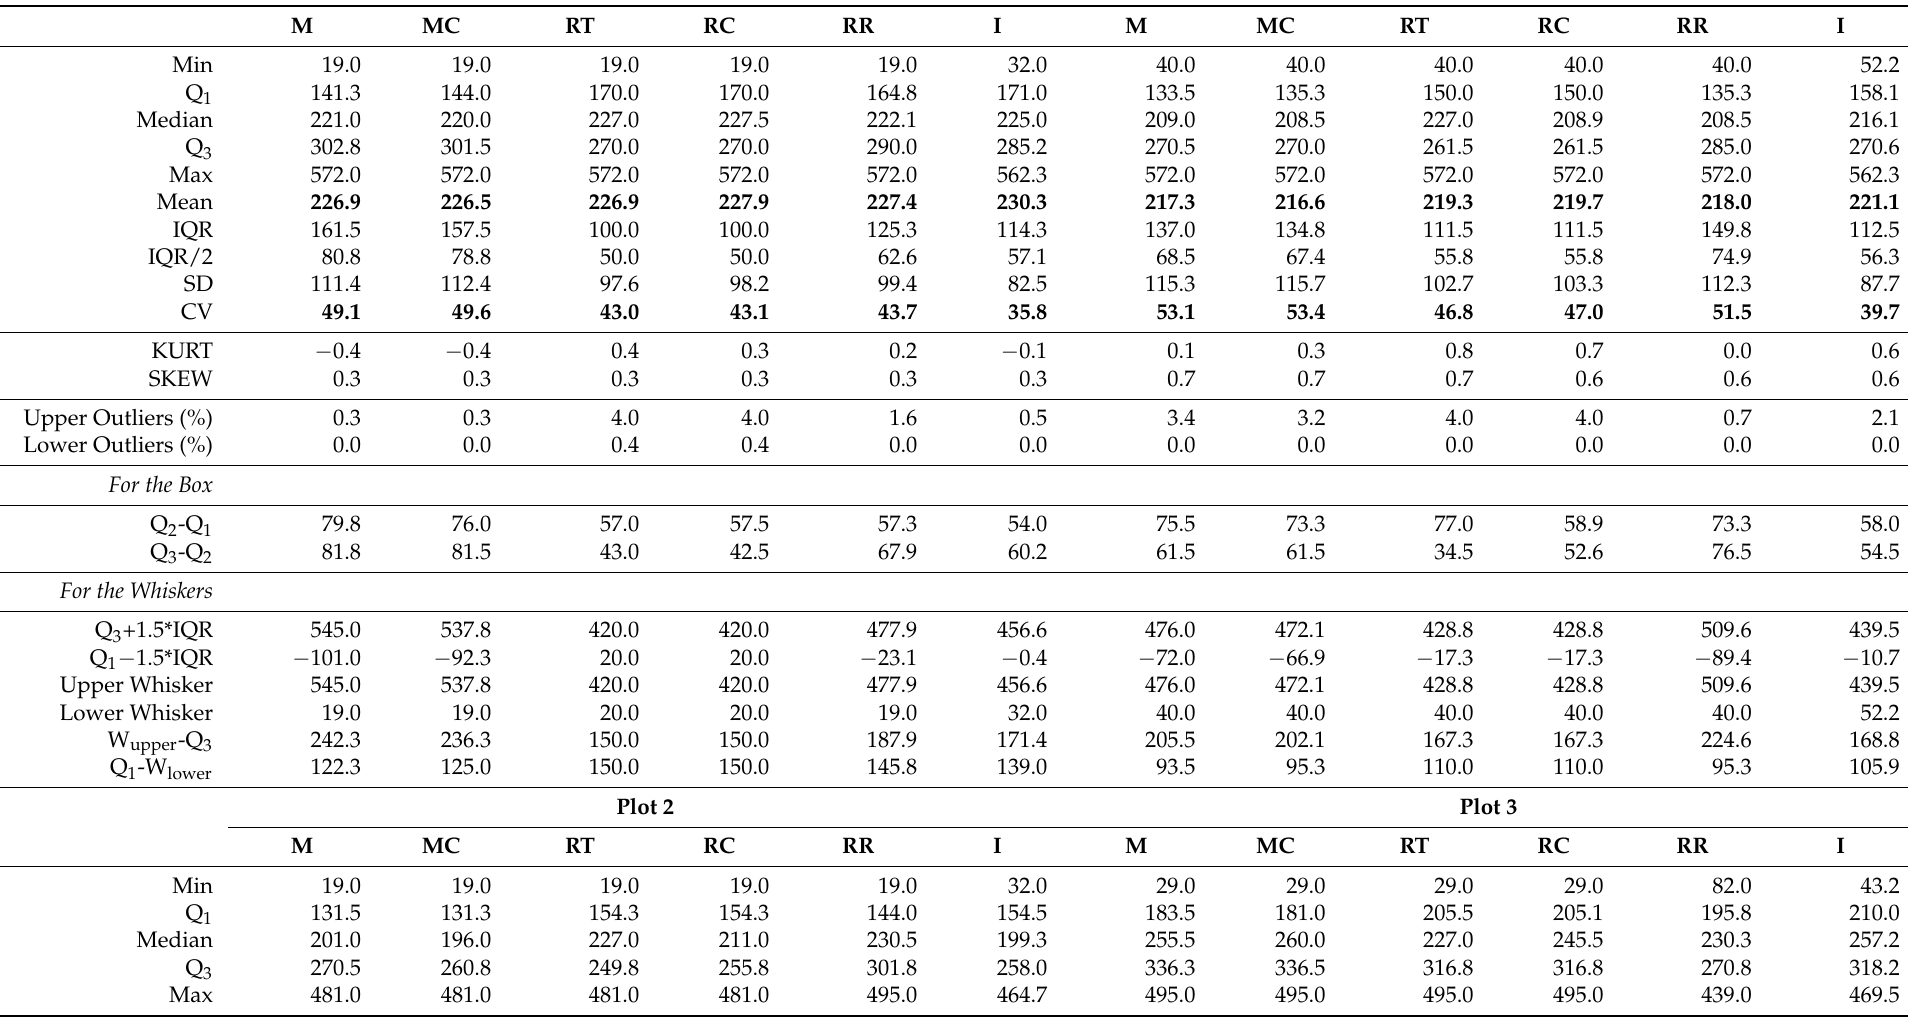
Table 3. Descriptive statistics for ear weight (EW)